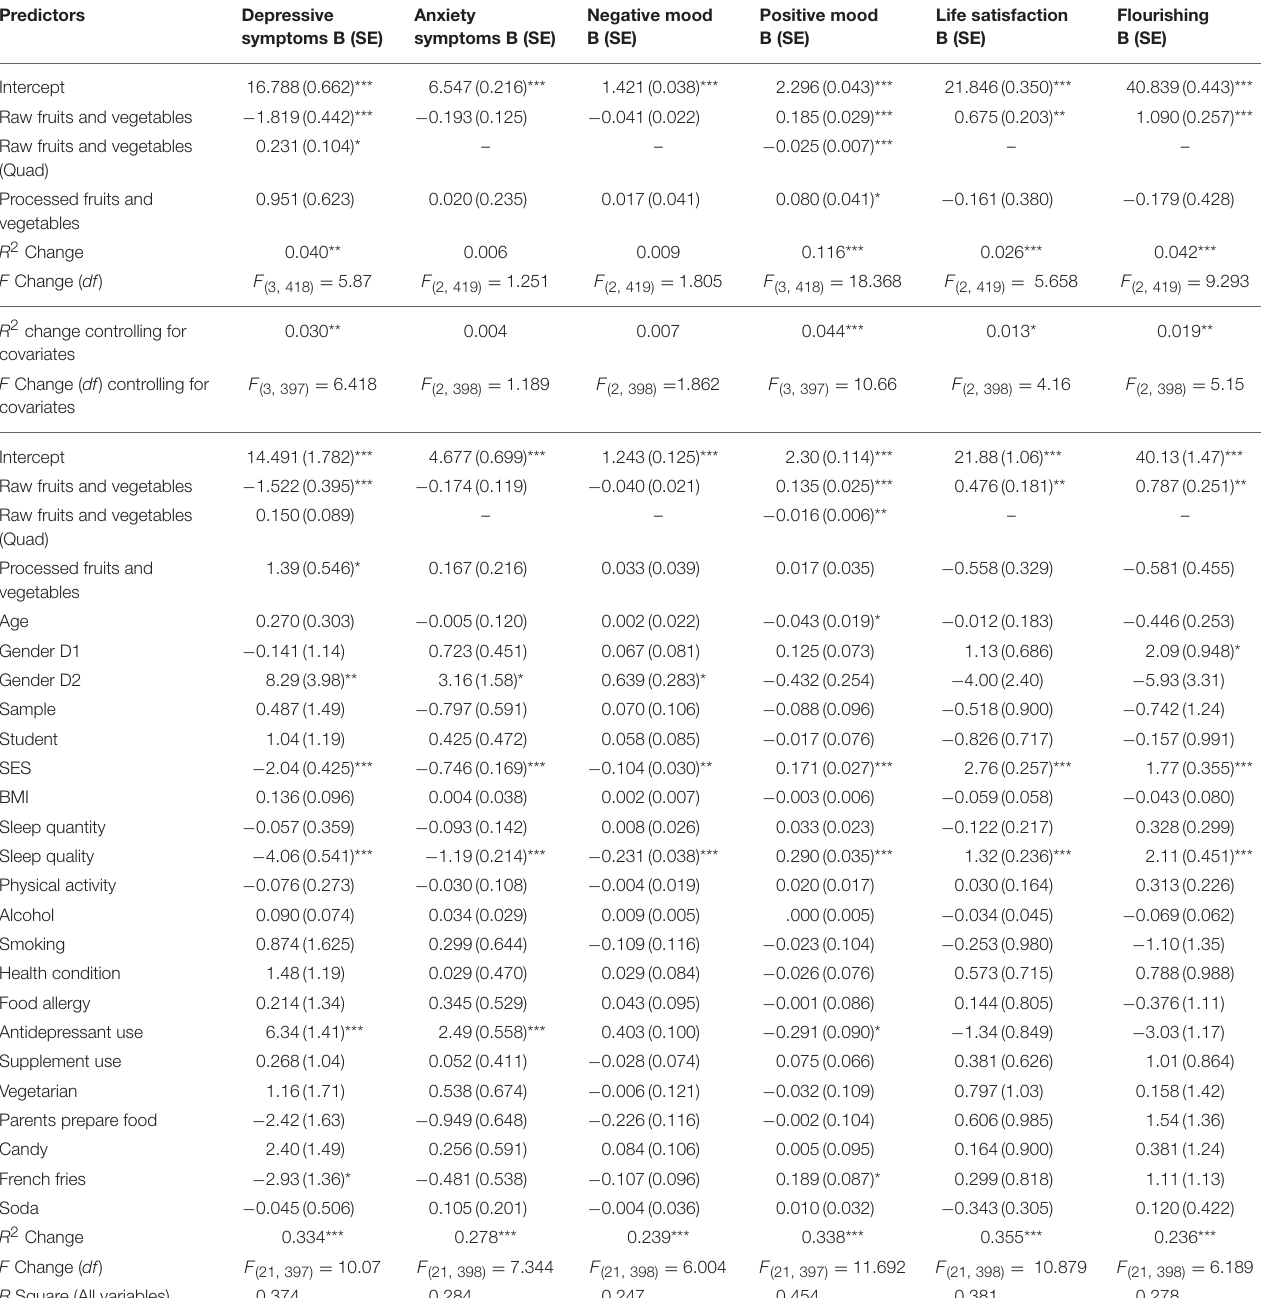
TABLE 5 | Regression models predicting mental health variables from fruit and vegetable intake, demographic covariates, and health related covariates.